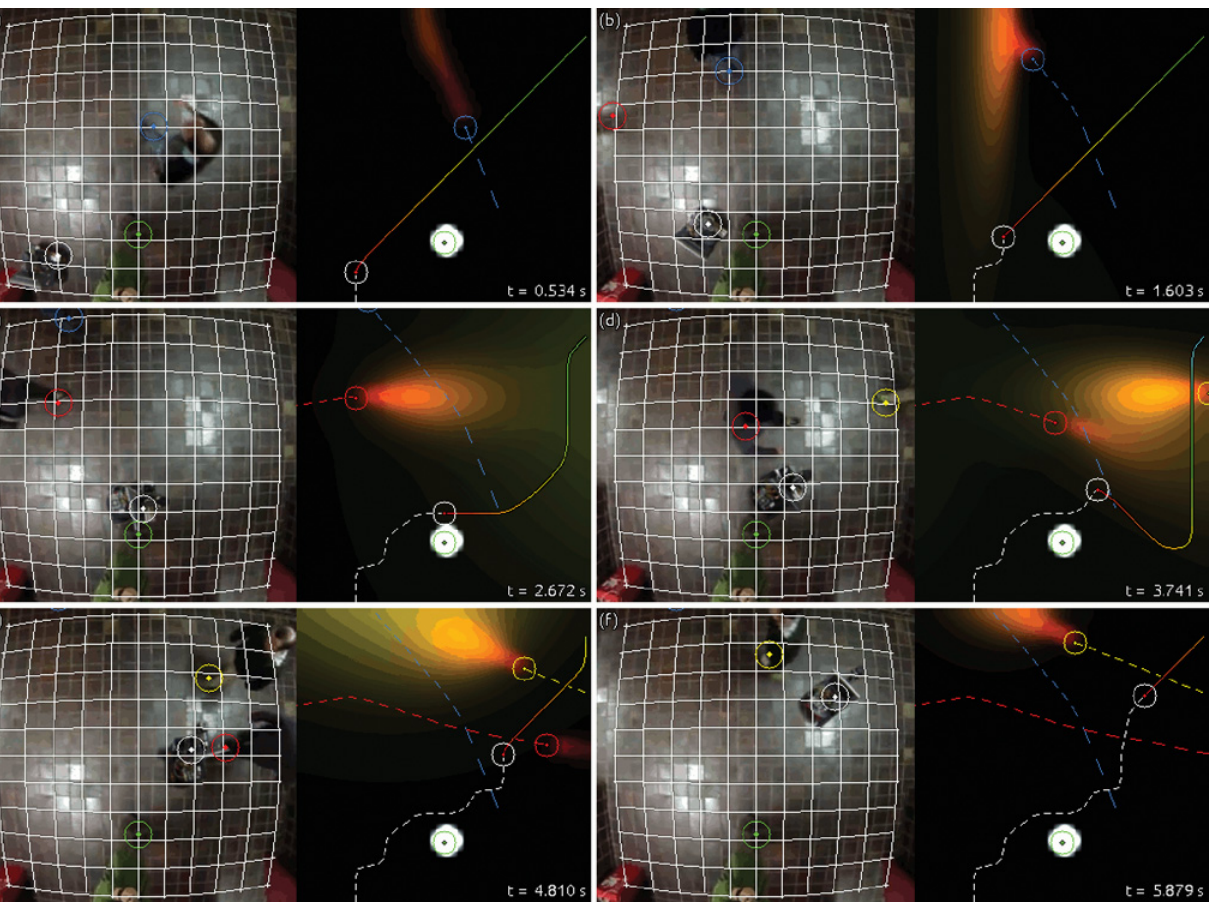
Fig 8. Example of sequential calculation of an optimal trajectory in a crowded environment. We use a workspace resolution of 50×50, a time window of T = 30 steps, and a minimum collision probability of (cid:2) = 0.1. The white dashed line represents the path that the robot has already followed, while the colored dashed lines show the observed movements of the